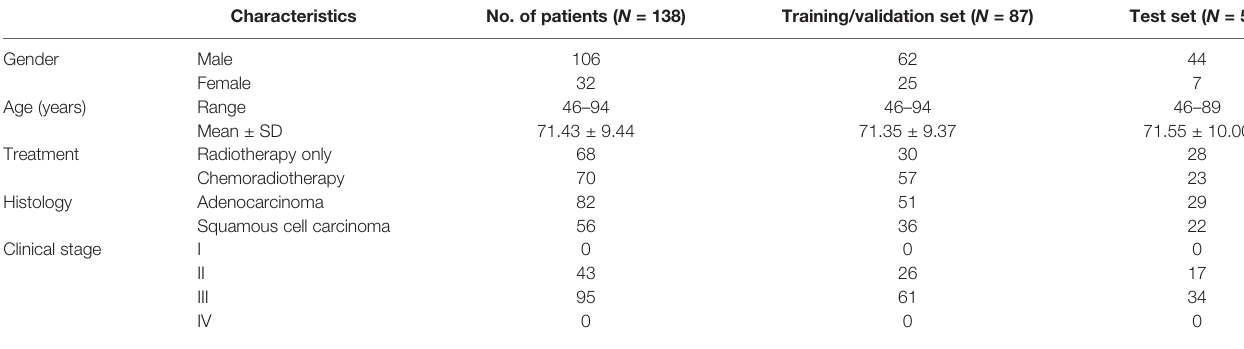
TABLE 1 | Patient